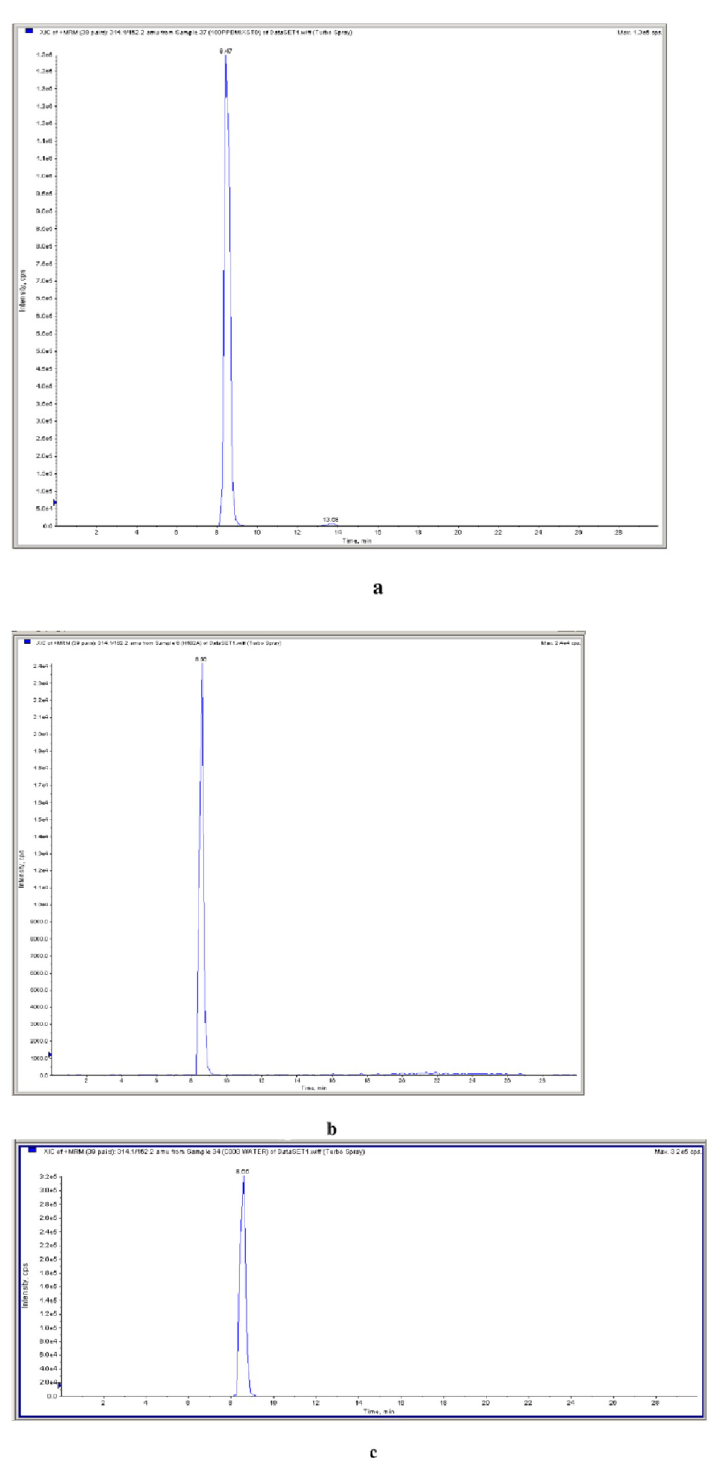
Fig 4. a. Standard chromatogram of Triazophas (standard). b. chromatogram of Triazophas In Blood sample of Case. c. chromatogram of Triazophas in water sample of Case.